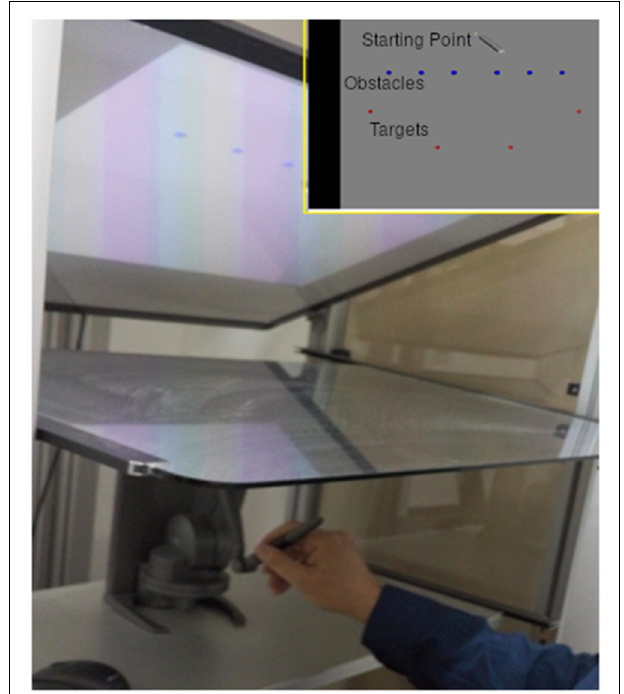
FIGURE 1 | Experimental setting. Participants performed a reaching movement holding a pen like stylus while looking down at a semi-transparent mirror (main image). They performed the movement from starting point to one of the targets (red) while avoiding the obstacles (blue) on the way (top right